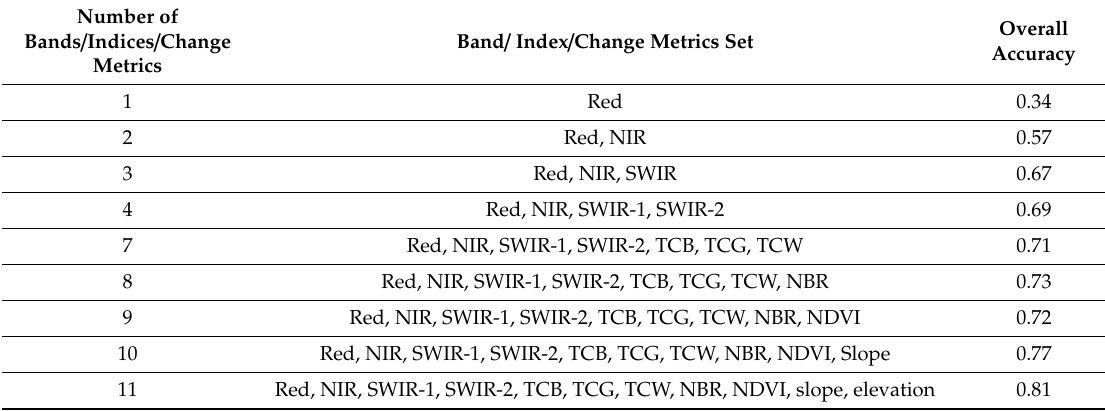
Table 2. Overall accuracy of the classification for di ff erent